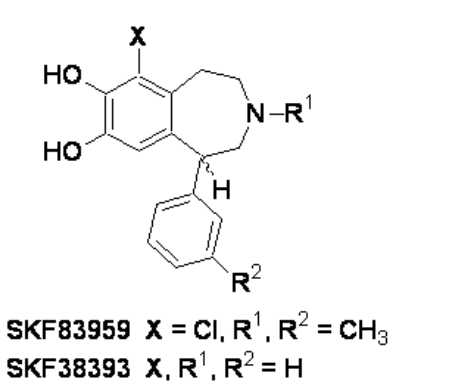
Figure 1. The structures of benzazepines.